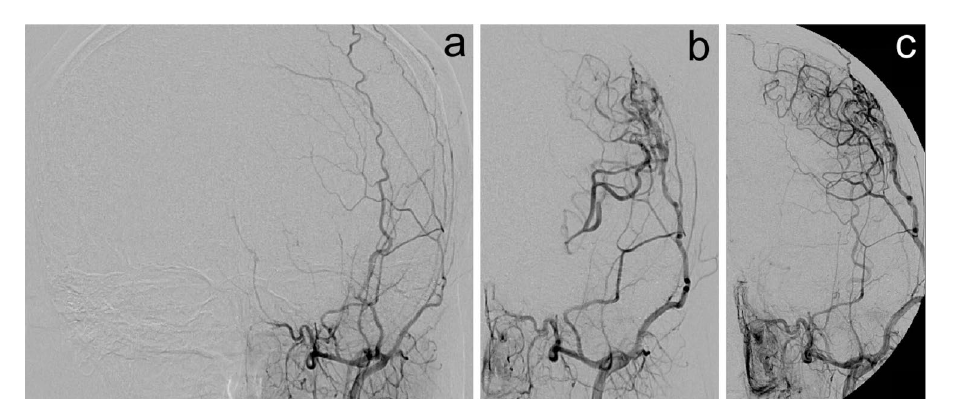
Figure 5. Digital subtraction angiography (DSA) images of the 11-year-old boy with MR perfusion maps shown in Fig. 4. ( a ) Anterior projection from external carotid artery injection right before the left EDAS operation in month + 0. ( b ) DSA performed in month + 5 shows moderate collateral development. ( c ) DSA image performed in month + 17 shows significant collateral development compared to ( b ) in the upper